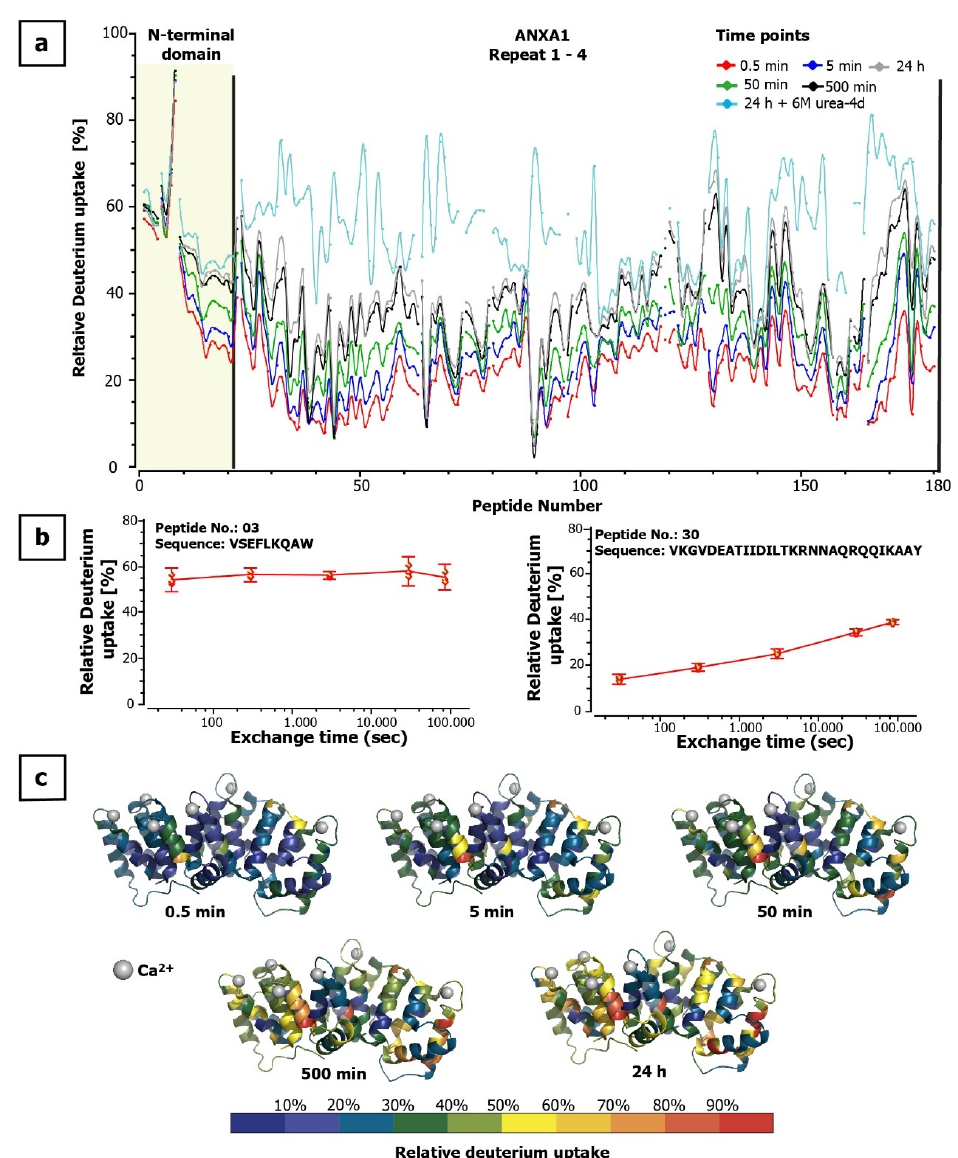
Figure 2. ANXA1 deuteration kinetics. ( a ) Relative deuterium uptake of 180 partially overlapping peptic peptides of ANXA1 numbered from N- to C-terminus over time. ( b ) Examples of deuterium uptake kinetics at peptide level: peptide #3: V5SEFLKQAW13 (left panel) showed very fast uptake whereas peptide #30: V58KGVDEATIIDILTKRNNAQRQQIKAAY85 (right panel) showed a slowly increasing uptake. ( c ) Heat map of deuterium uptake mapped onto the ribbon crystal structure of human ANXA1 taken from PDBe (1AIN [24]) using PyMOL (v2.0.7 http://www.pymol.org (accessed on 24 December 2020) and HDExaminer (v2.5.0, http://massspec.com/hdexaminer (accessed on 24 December 2020)) with medium smoothing for the partially overlapping peptic peptides. Dark blue regions showed a very slow exchange kinetics, indicating a compact, hardly accessible